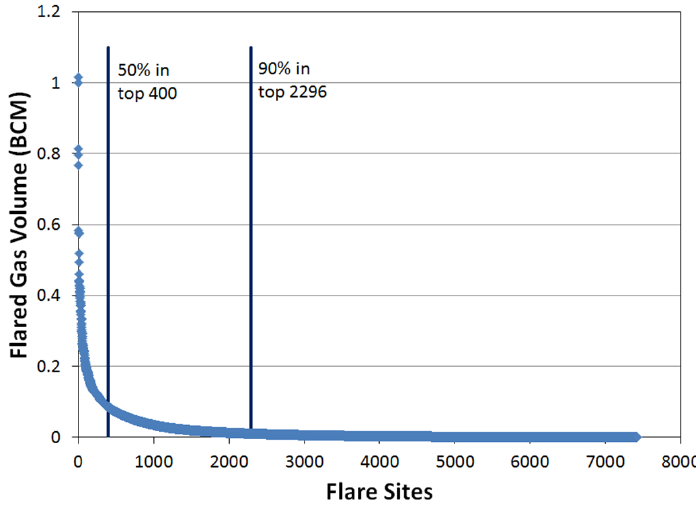
Figure 10. VIIRS estimate flared gas volumes for 7467 gas flares, worldwide. This includes both upstream, downstream and LNG terminal flare sites.